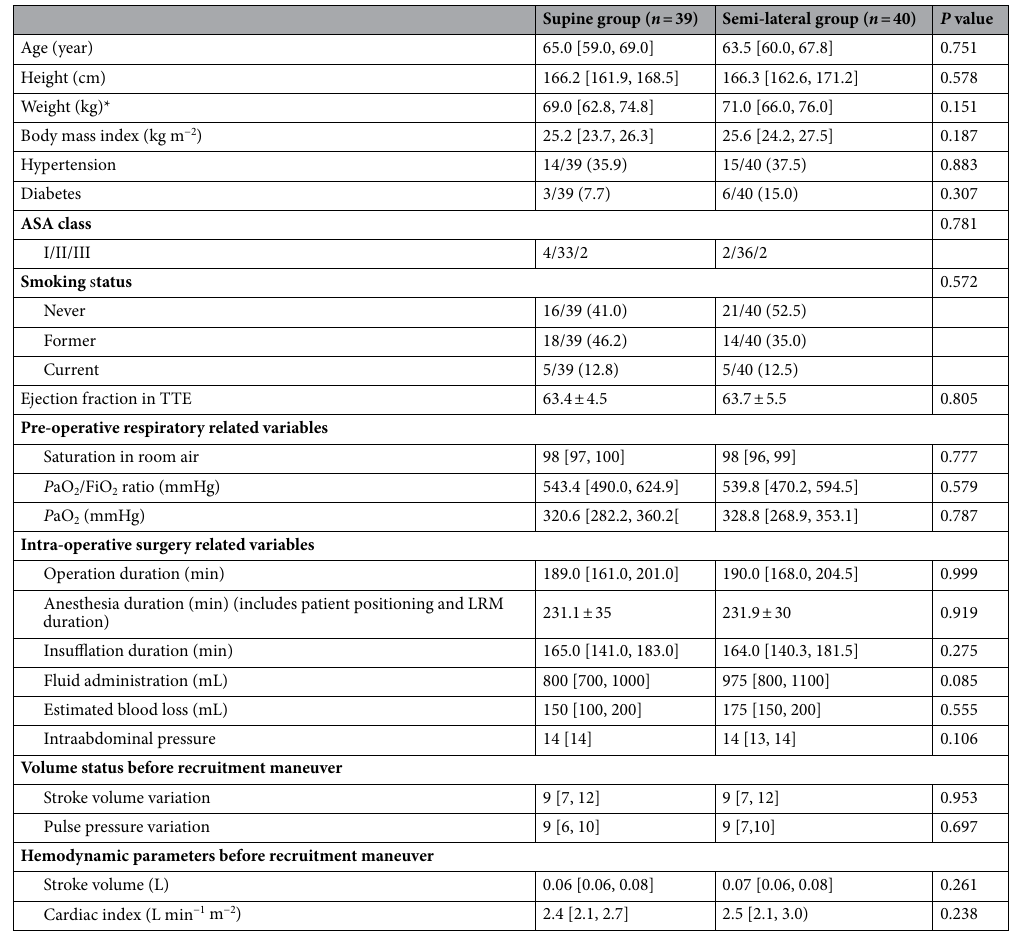
Table 1. Baseline characteristics between the supine position group and the semi-lateral position group. Data are presented as the median [25th percentile, 75th percentile] or frequency (percent). ASA American Society of Anesthesiologist, TTE transthoracic echocardiography.